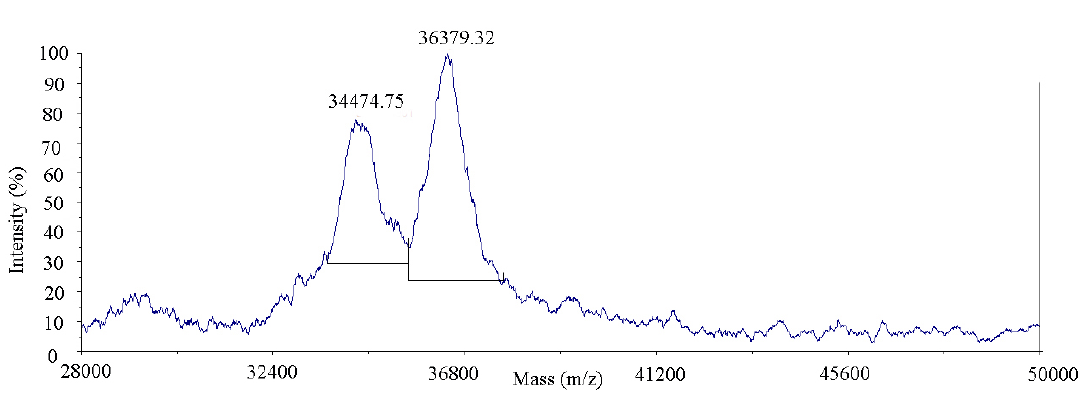
Figure 2. MALDI-TOF-MS analysis of Pv–GA complex.